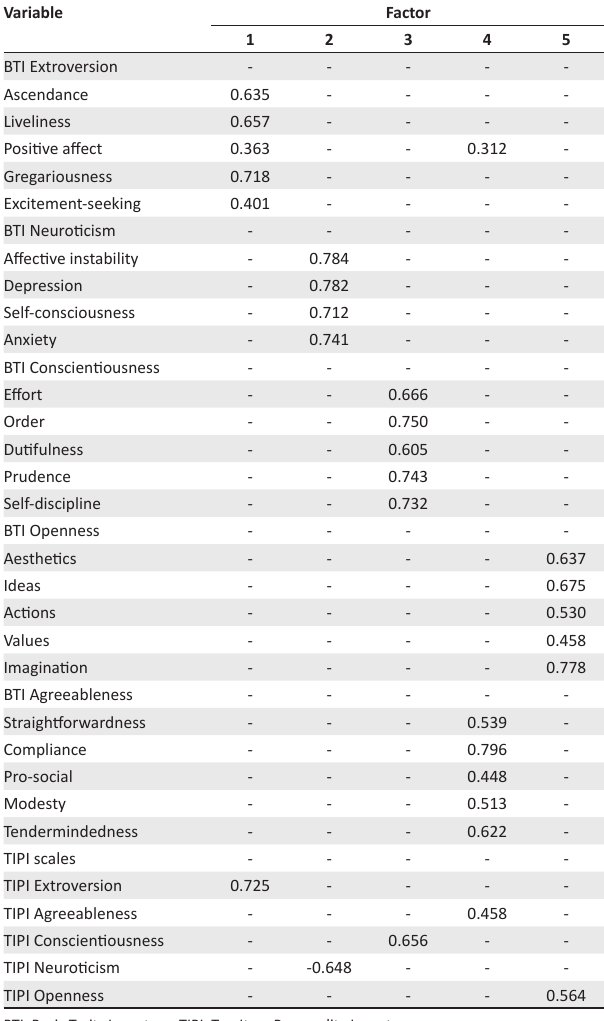
FIGURE 1: The scree and parallel analysis plot. TABLE 3: Direct quartimin rotated factor pattern matrix of the BTI facets and TIPI